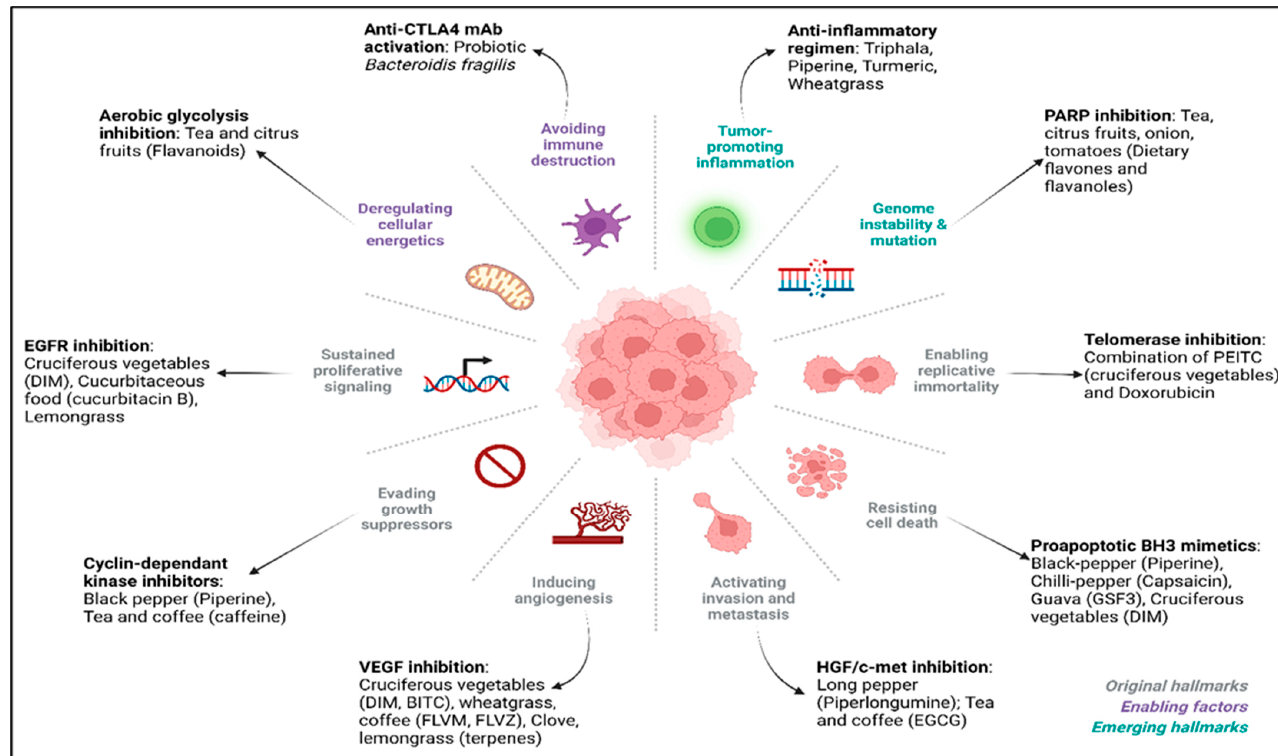
Figure 4. Hallmarks of cancer (original hallmarks, enabling factors, and emerging hallmarks) along with their corresponding therapeutic targets and various food constituents acting through it. (Figure created with Biorender.com).